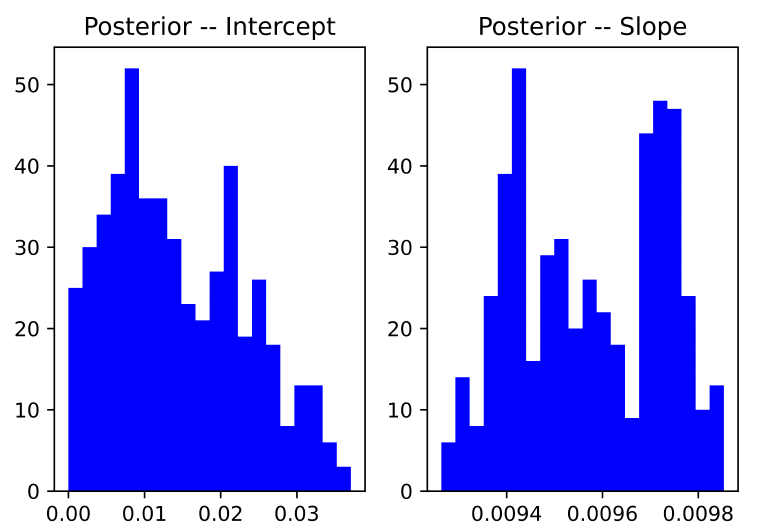
Figure 1. The posterior distributions of the linear regression fitting parameters for PV power genera- tion against forecast solar luminosity for Task 4.